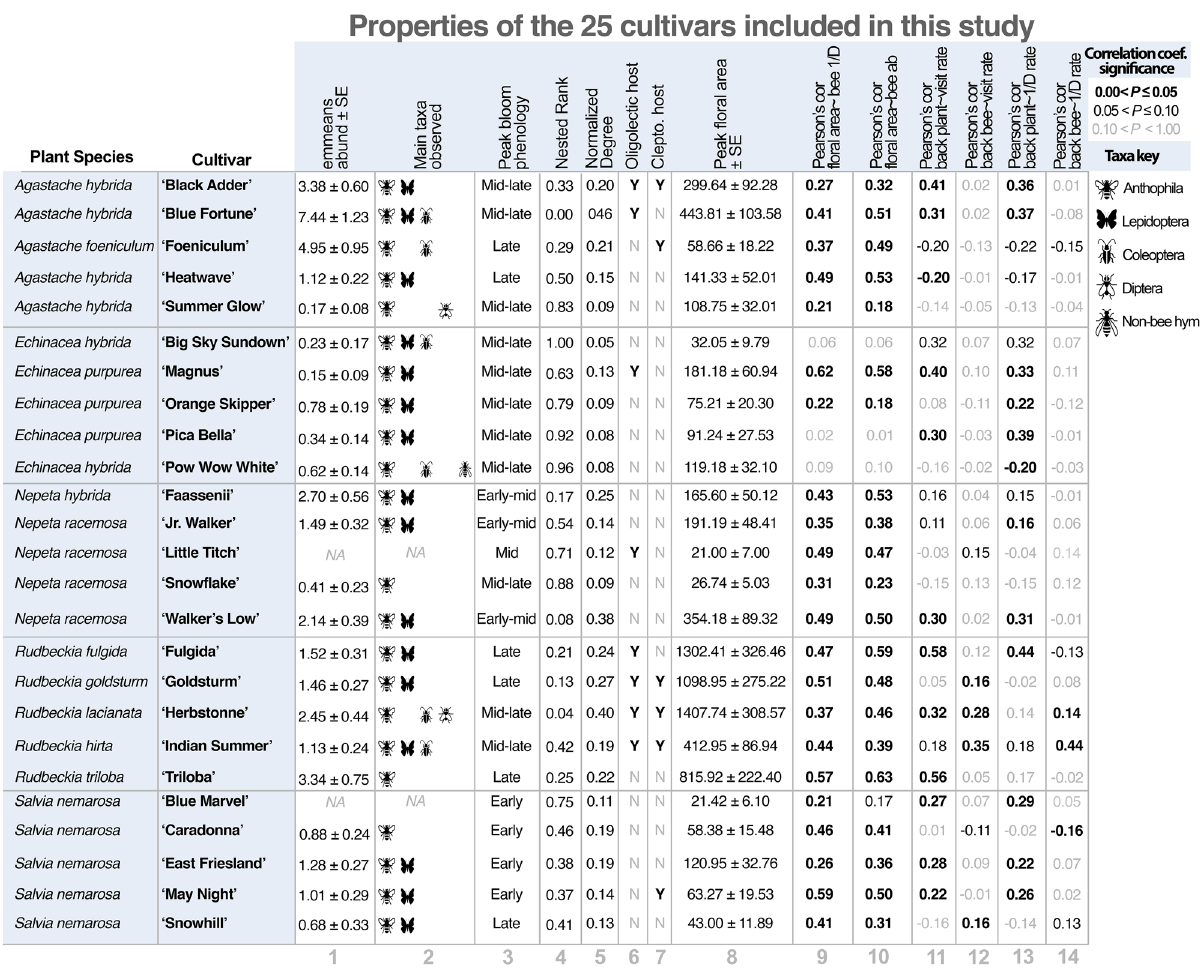
Table 1. Summary of results of the quantitative analyses. 1 the estimated marginal means of total visitor abundance and 2 the primary taxonomic groups observed visiting the cultivars in this study. 3 the period during the growing season (May - September) during which the cultivar is in peak bloom. 4,5 the Nested Rank (NR) and Normalized Degree (ND) of each cultivar in a plant–pollinator network and whether that cultivar hosted 6 oligolectic or 7 cleptoparasitic bee species, based on data from snapshot collections. 8 the mean peak floral display area for each cultivar. Pearson’s correlation coefficients and the significance of correlation tests between floral display area and 9,10 bee diversity and abundance. Pearson’s correlation coefficients and the significance of correlation tests between bee abundance ( 11,12 ) and diversity ( 13,14 ) rates (standardized by floral display area) and background plant and bee